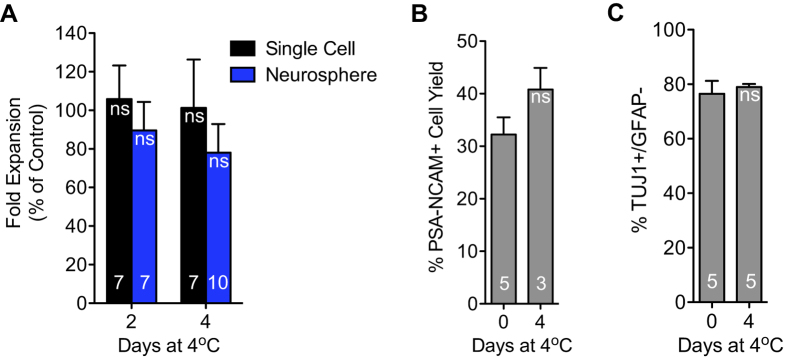
Characterization of hNPCs subjected to 2–4 days at 4 °C.(A) Fold expansion rate of cells serially passaged (a minimum of 4 passages) after 2–4 days incubation at 4 oC was not significantly affected compared to control. Cells incubated as single cells proliferated the same amount as cells incubated as un-dissociated neurospheres. (B,C) hNPCs incubated at 4 oC performed similarly to control when differentiated for six days in the neuroblast assay, regarding number of PSA-NCAM+ cells yielded per originally plated (B) and proportion of TUJ1+/GFAP− cells amongst the unpurified yield (C). Means + s.e.m. *P < 0.05, ns means not significant, by unpaired two-tailed t test. The numbers on bars indicate the numbers of cell passages or number of neuroblast assays, including two different thawed cell vial sources.